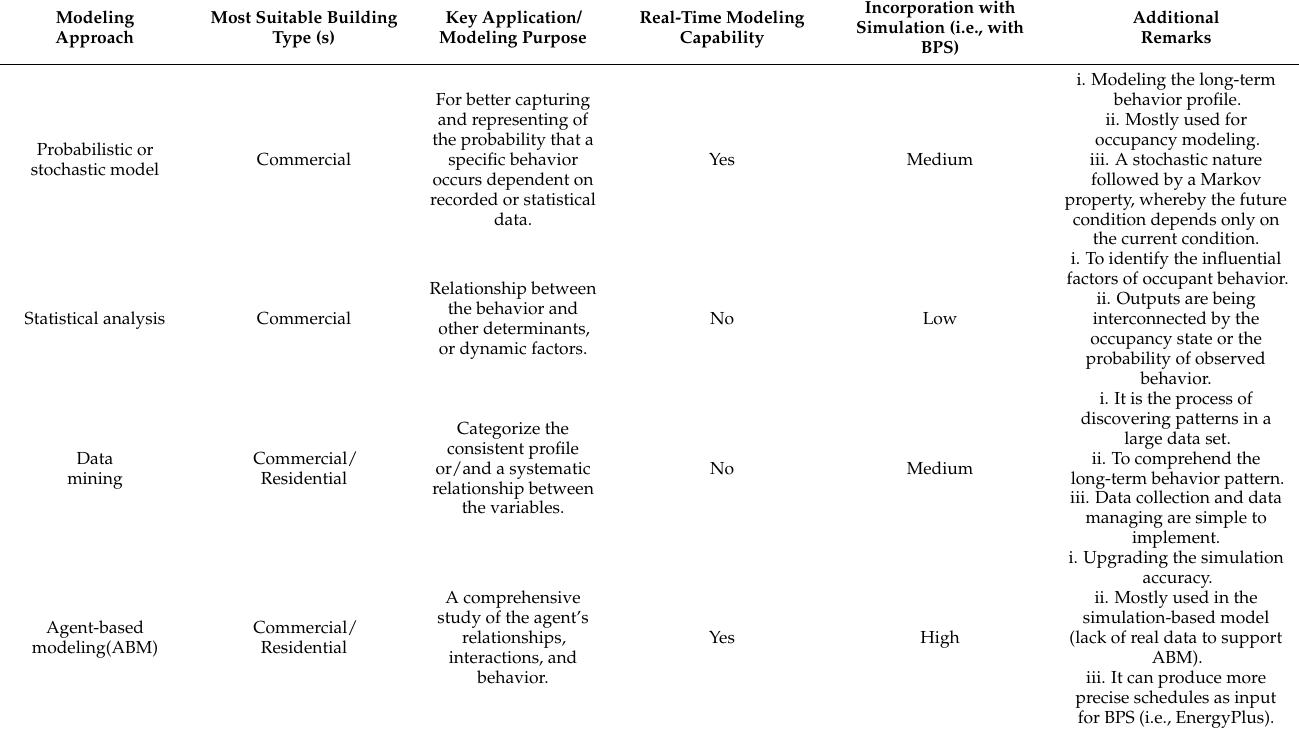
Table 2. A brief comparison of the different modeling